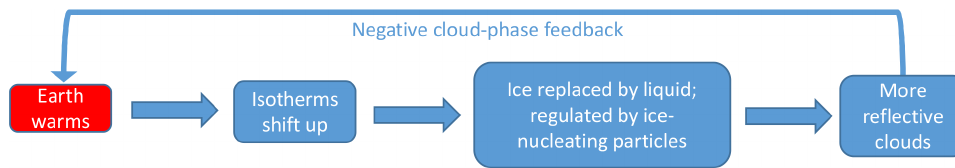
Figure 2. The cloud-phase feedback and its relationship with ice-nucleating particles (based on Storelvmo et al., 2015). For shallow marine clouds, the replacement of ice by liquid water leads to more reflective clouds and less shortwave radiation reaching the low albedo ocean surface, resulting in a negative climate feedback.